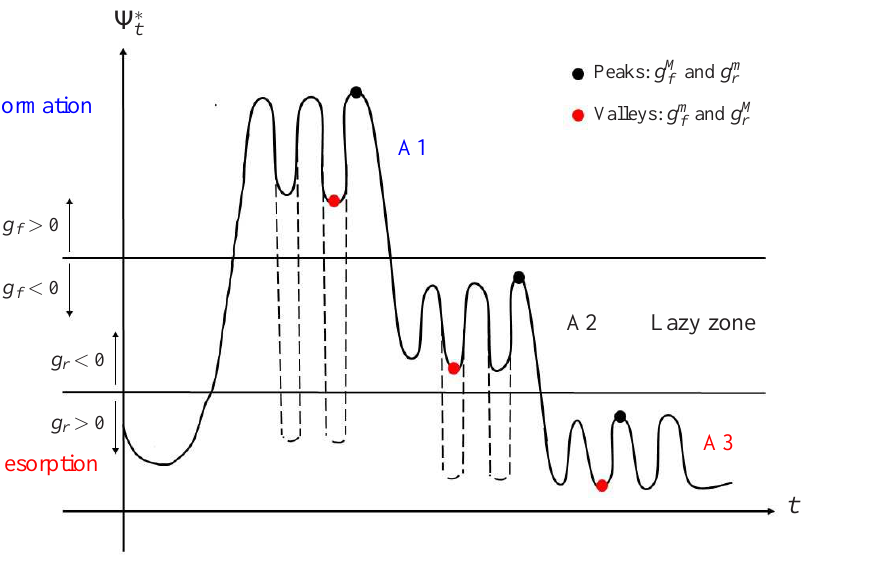
Figure 5. Remodelling criteria with different loads. The horizontal lines limit the zones of formation (top line) and resorption (bottom line). If the peak is over the top line, then g M and formation occurs. If the peak is below the bottom line, then g M occurs. If the peak lies between both lines, g M occurs (lazy